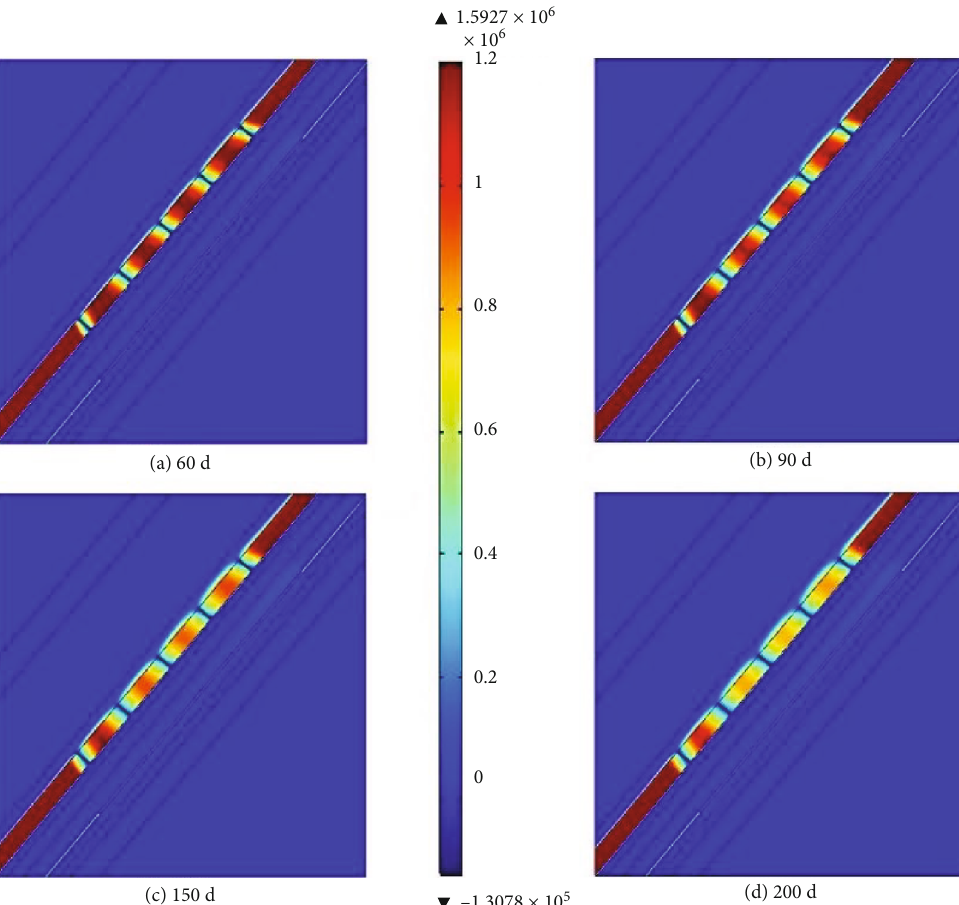
Figure 7: Scheme of gas pressure distribution of gas drainage with pressure-relief (inclined).